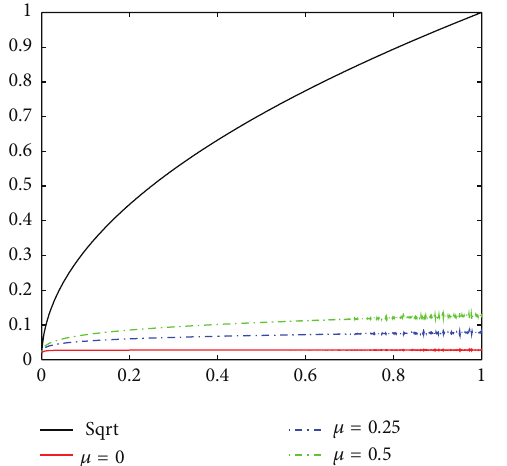
Figure 5: The outcome of the fractional signal when 𝛼 = 1